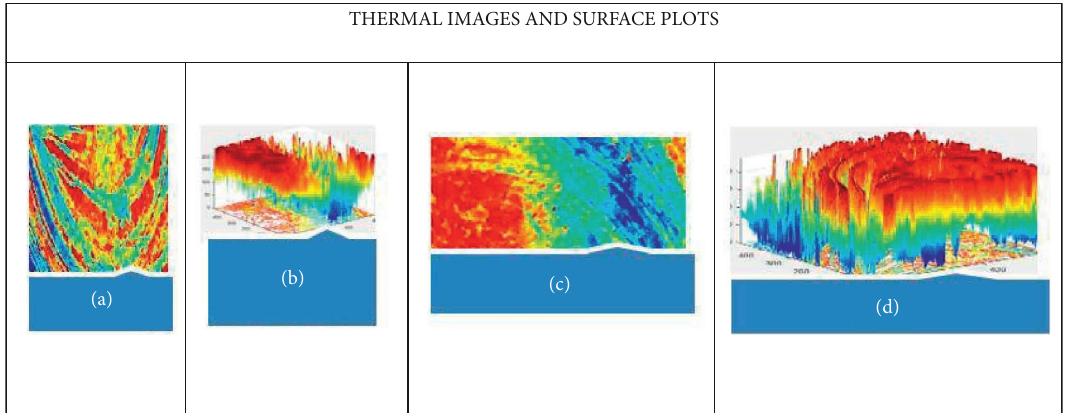
Figure 4: Metal surface and 3D plots. (a) Good thermal image. (b) Good thermal image surface plot. (c) Bad thermal image. (d) Bad thermal image surface